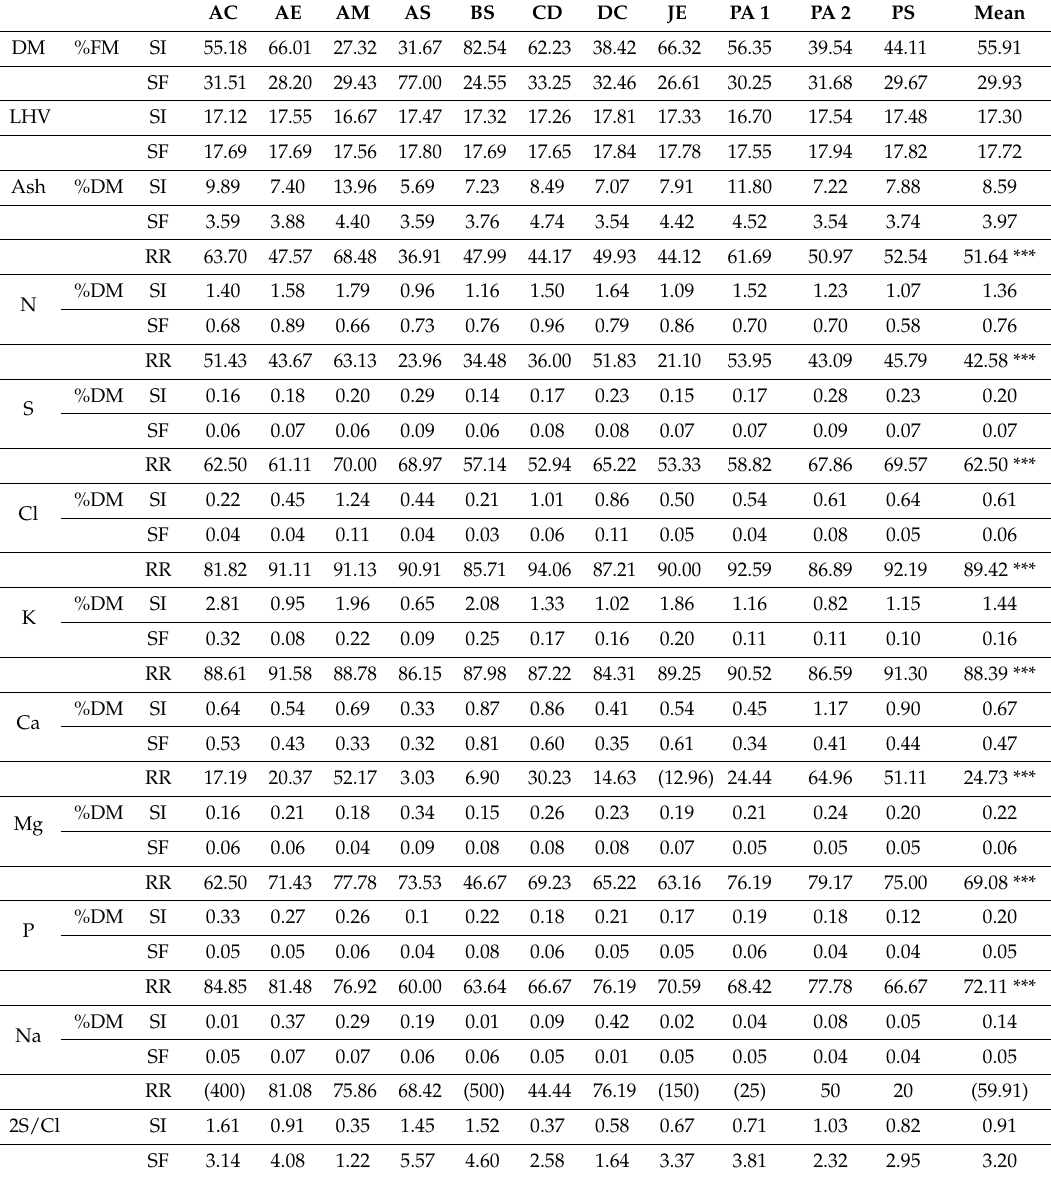
Table 3. Ultimate analysis, heating values, elemental concentration and corrosion index for silage (SI) and solid fuel (SF), along with the reduction rate (RR) from silage to solid fuel for test materials processed in the commercial-scale pilot plant (see Table 1). The values in parentheses denote an increase in concentration from silage to press